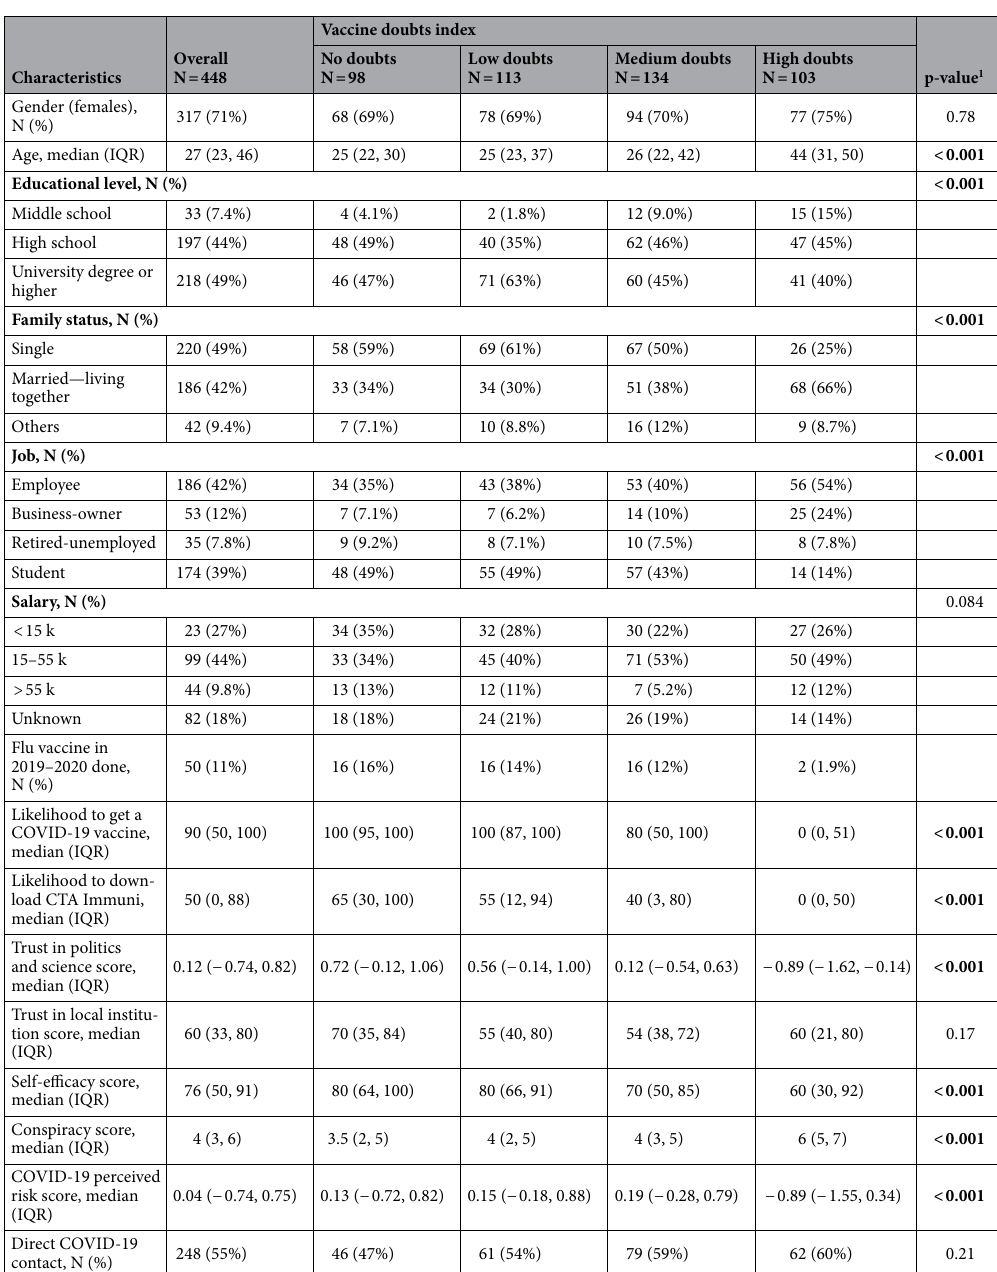
Table 1. Main characteristics of the participants, overall and by degree of vaccine doubts index. Tests are performed between characteristics and categories of vaccine doubts index. Significance values are given in bold. 1 Pearson’s Chi-squared test; Kruskal–Wallis rank sum